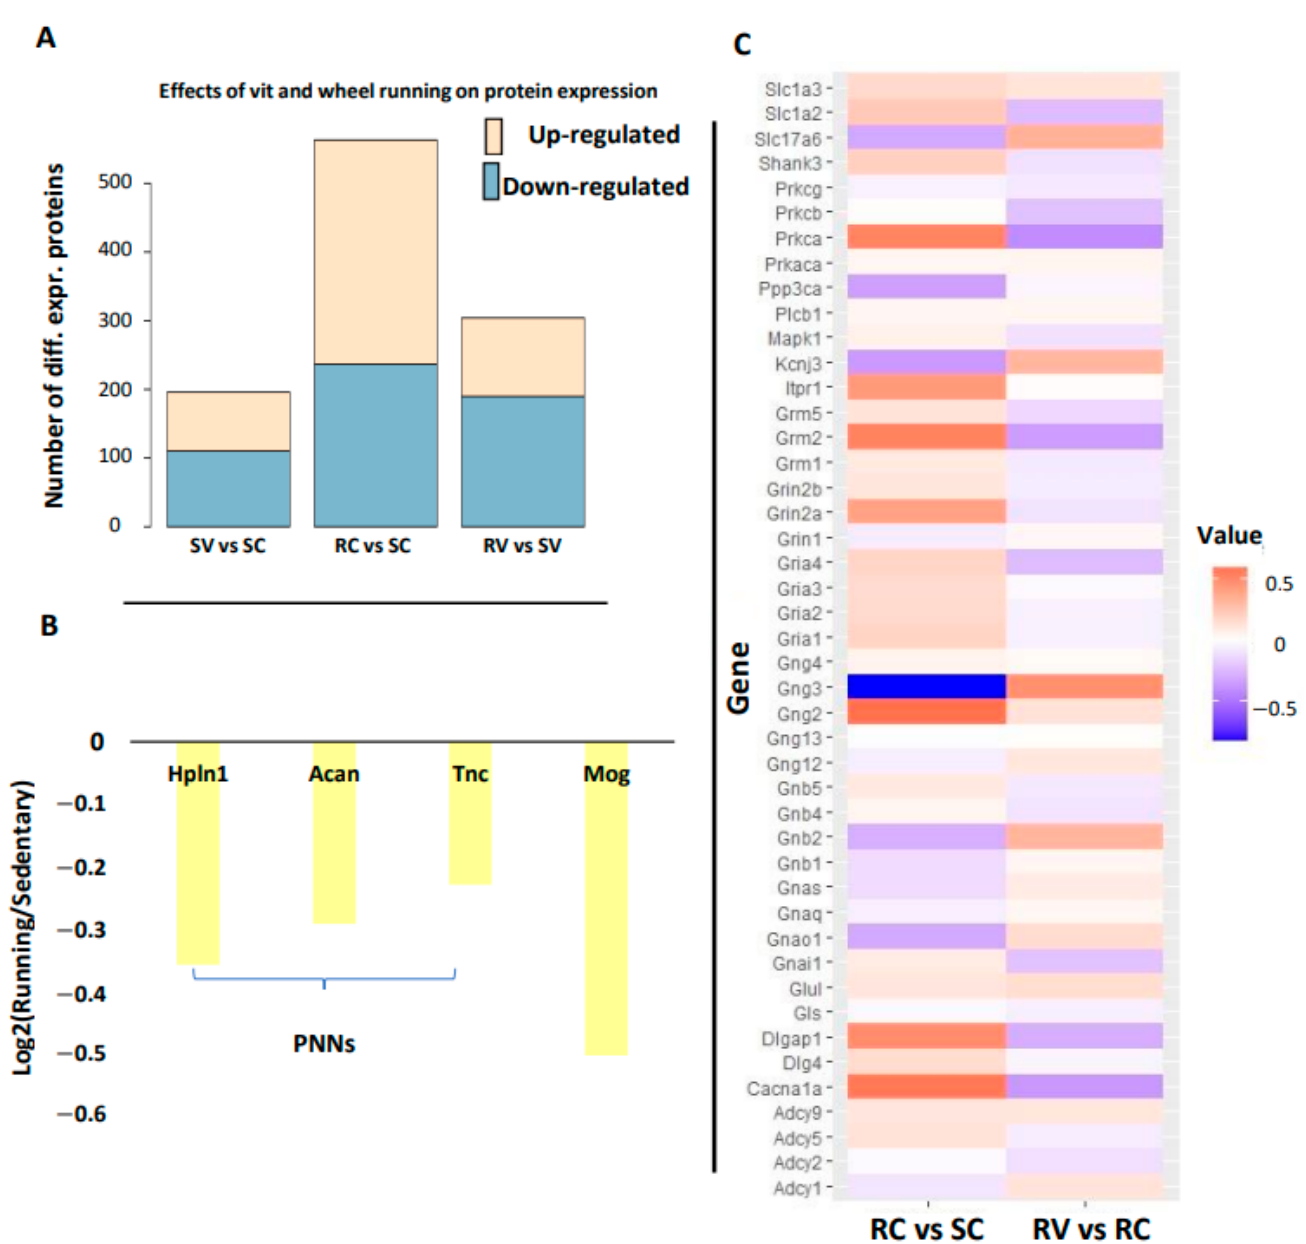
Figure 4. Mass-spectrometry based analysis of protein expression from visual cortical samples. ( A ) The number of differentially expressed proteins in RC vs. SC and RV vs. SV contrasts. Pink bars indicates up-regulation and grey bars down-regulation. The fraction of up-regulated proteins over the total number of detected proteins is significantly decreased in the RV vs. SV contrast (11.1 % vs. 3.9%, p < 10–16, Fisher’s exact test). ( B ) Regulation of key plasticity brakes in RC vs. SC. The average fold change is reported. Tnc = tenascin, Acan = aggrecan and Halpn1 = Hyaluronan and proteoglycan link protein 1 are components of the perineuronal nets (PNNs). Mog = Myelin oligodendrocyte glycoprotein is a constituent of myelin. All differences are statistically significant. ( C ) Regulation of proteins belonging to the KEEG Pathway “Glutamatergic synapse” rno04724 in the RC vs. SC and in the RV vs. RC comparisons displayed as heatmap. Out of 114 genes in the pathway, 45 were detected at the protein level. Red: increased expression; blue: decreased expression. Vitamin supplementation counteracts the up-regulation of protein involved in the glutamatergic